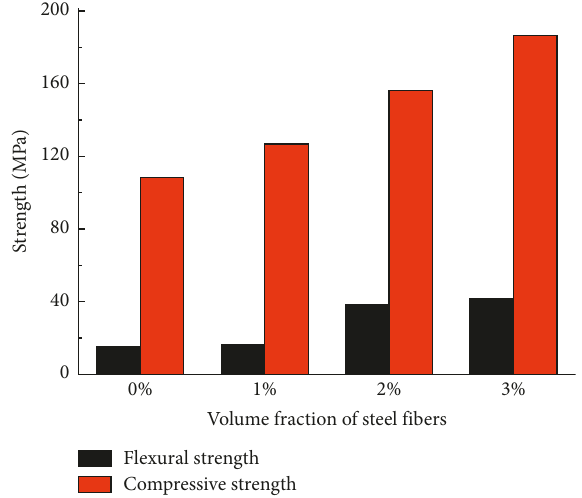
Figure 3: Relative dynamic modulus of elasticity of UHPCs at different freezing-thawing